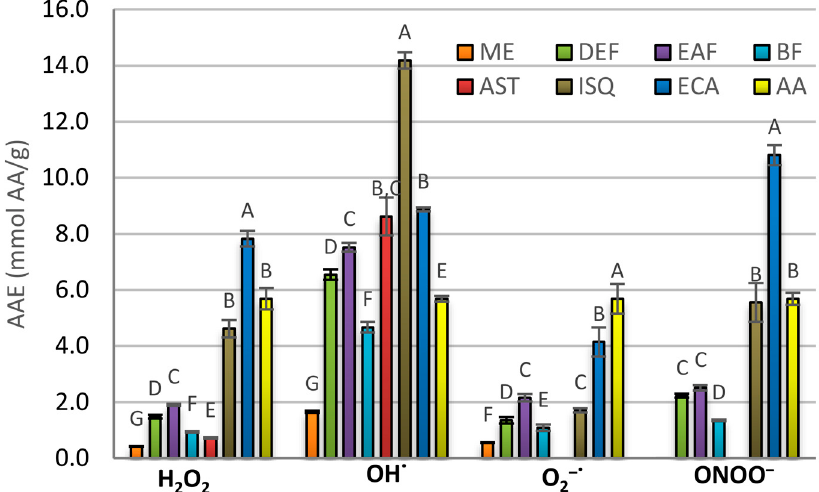
Figure 3. Scavenging activity of the extracts from the flower of A. hippocastanum and its selected constituents towards reactive oxygen species (ROS), expressed as ascorbic acid equivalents (AAE). Results presented as means ± SE ( n = 5). ANOVA and post hoc tests for multiple comparisons were run foreach ROS separately, and the values statistically different at α = 0.05 were labeled with different capital (A–G). Analytes: ME—methanol extract; DEF—diethyl ether fraction; EAF—ethyl acetate fraction; BF— n -butanol fraction; AST—astragalin; ISQ—isoquercitrin; ECA—( − )-epicatechin; AA—ascorbic acid.